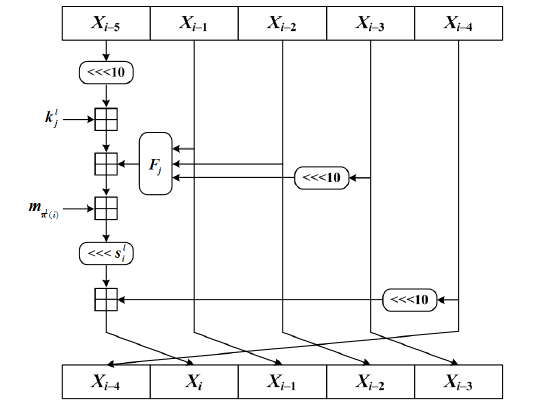
Figure 1: The left branch of step update transformation of